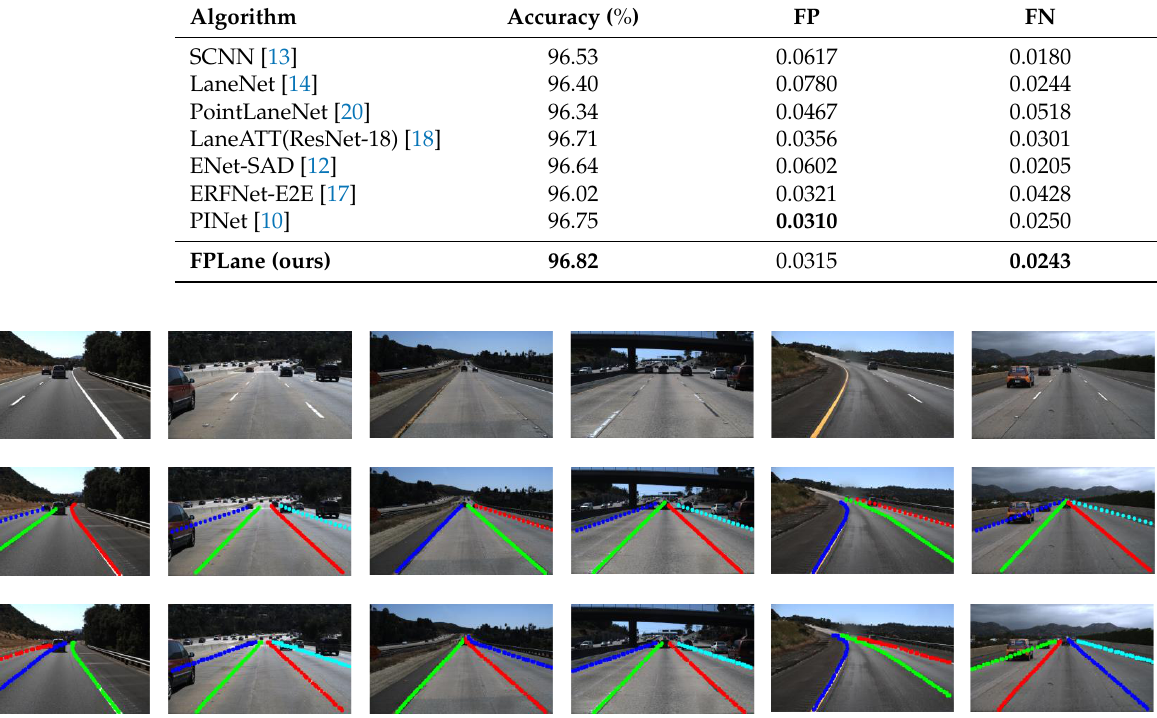
Figure 7. Visualized results of FPLane on TuSimple testing set. The second row is labels and the third row is predicted results of